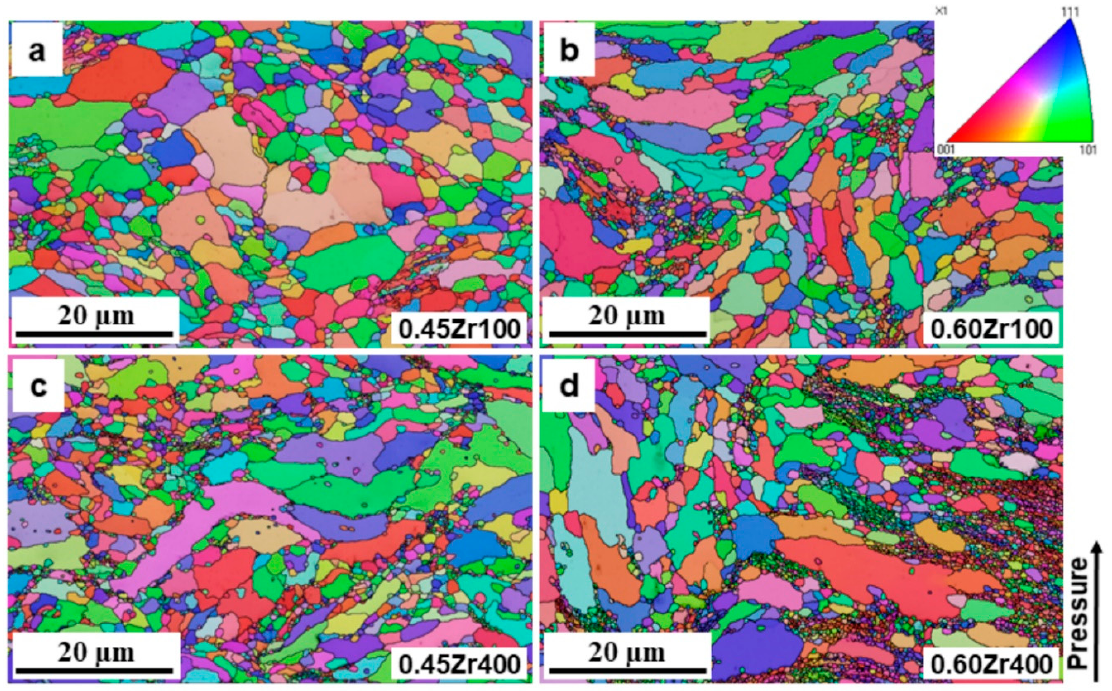
Figure 2. IPF-EBSD maps on the ODS alloys: ( a ) ODS-0.45Zr100 sintered at 100 °C·min − 1 , ( b ) ODS-0.6Zr100 sintered at 100 °C·min − 1 , ( c ) ODS-0.45Zr400 sintered at 400 °C·min − 1 , ( d ) ODS-0.60Zr400 sintered at 400 °C·min − 1 .